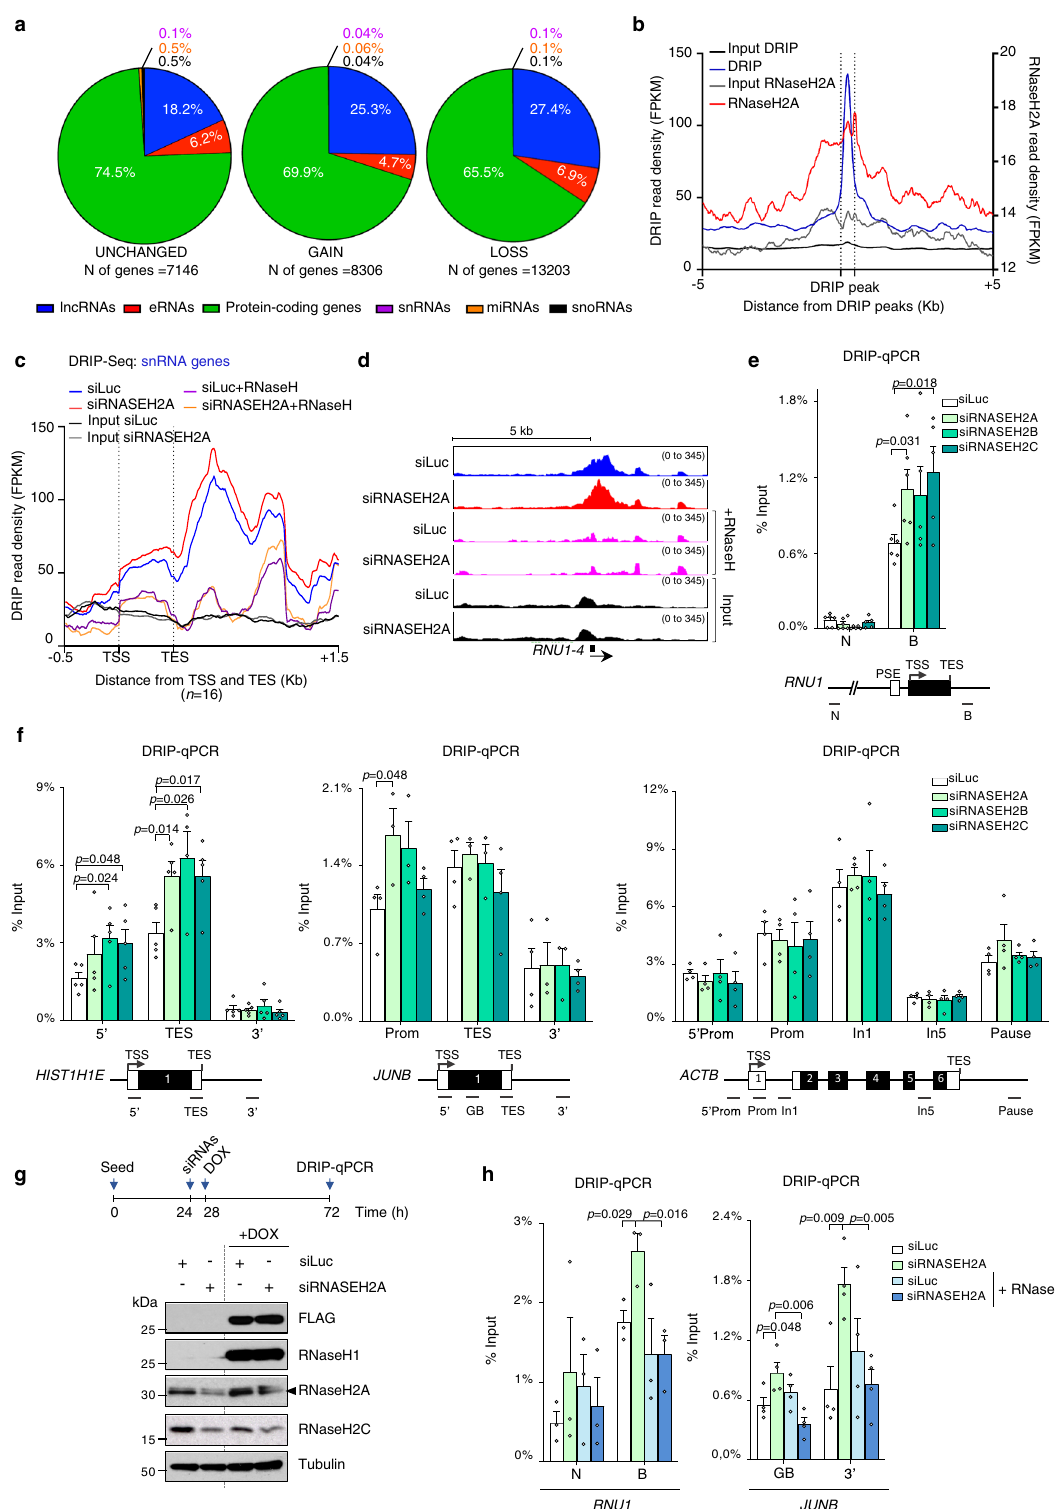
R-loops in RNase H2-de fi cient cells are short, intronless and highly expressed, such as snRNA and histone genes. This bias towards short genes may be explained by the ability of introns to limit R-loop accumulation through splicing, especially upon de fi ciency of physiological R-loop regulators, such as THO factors 58,59 . Considering the multitude of R-loop regulators in human cells 60 , intron-containing and long genes may employ